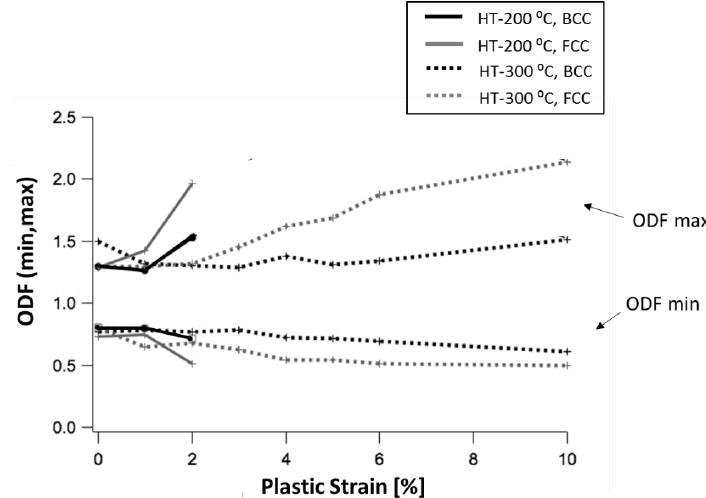
Figure 12. Evolution of the minimum and maximum orientation distribution function (ODF) intensity values of bcc (bct) and fcc phases, analysed by neutron diffraction, as a function of the plastic strain during a tensile test, for two nanobainitic structures from the same steel after customized isothermal treatments at 200 and 300 °C. Adapted from reference [69].